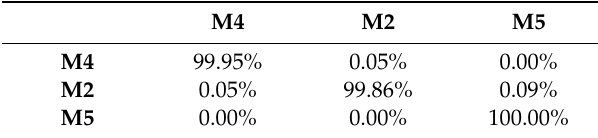
Table 4. Signal misperceptions for motors: horizontal axis.